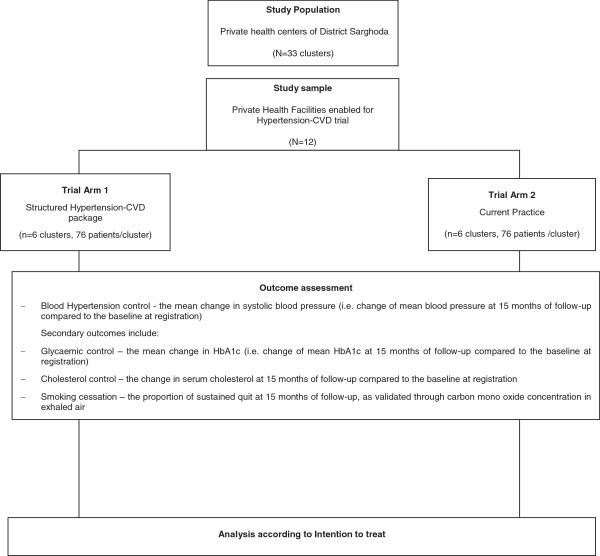
Flow chart of study.